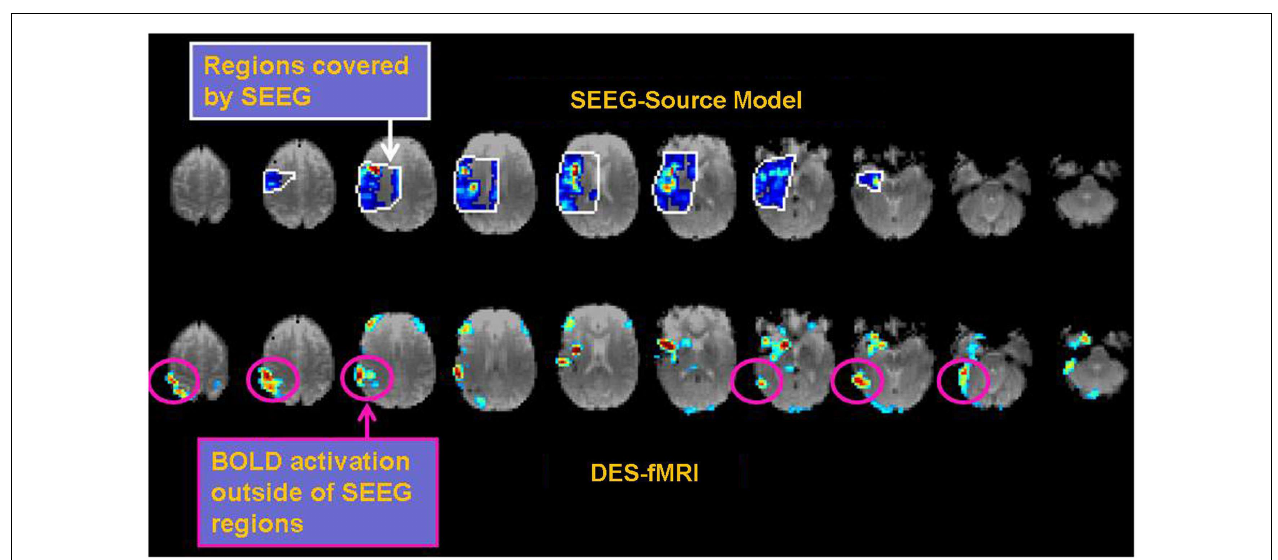
(region bounded by white line), and may offer superior comparison to other methods of connectivity. Note the region of reliable results is only covers a minority of the entire brain.The bottom row shows the corresponding DES-fMRI BOLD connectivity map derived from stimulation of the same electrode-pair as the top row.While there is qualitative correspondence of the connectivity maps in the region of the temporal lobe and insula, the DES-fMRI map encompasses the entire brain and reveals strong areas of activation outside the coverage of SEEG electrodes, namely in the right parietal lobe. Establishing a reliable relation between these two measures of connectivity could synergistically enhance the coverage of invasive